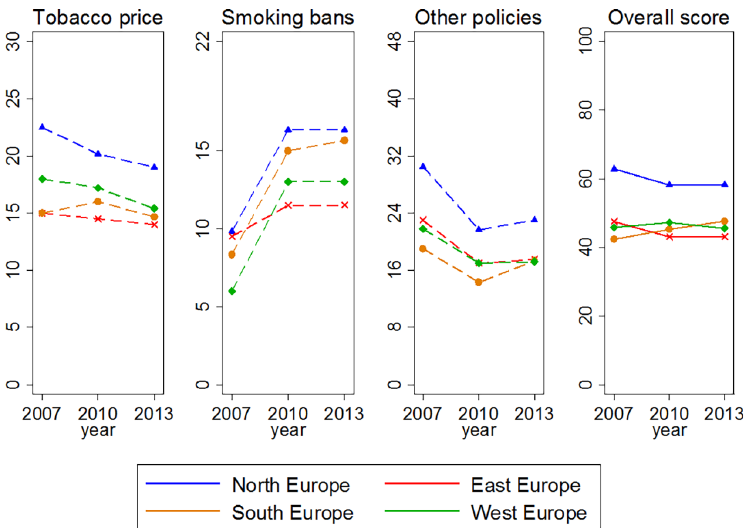
Fig 3. Trends in implementation of tobacco control policies by European region (2007–2013). Plots obtained using the Tobacco Control Scale scoring system from Joossens & Raw [23,38,39]. Markers indicate mean scores for the countries included in the study, with the exception of Macedonia in East Europe (not available). Y-axes show theoretical ranges. “Other policies” is the combination of spending for public information campaigns, bans on advertising, health warning labels, and treatment for smoking